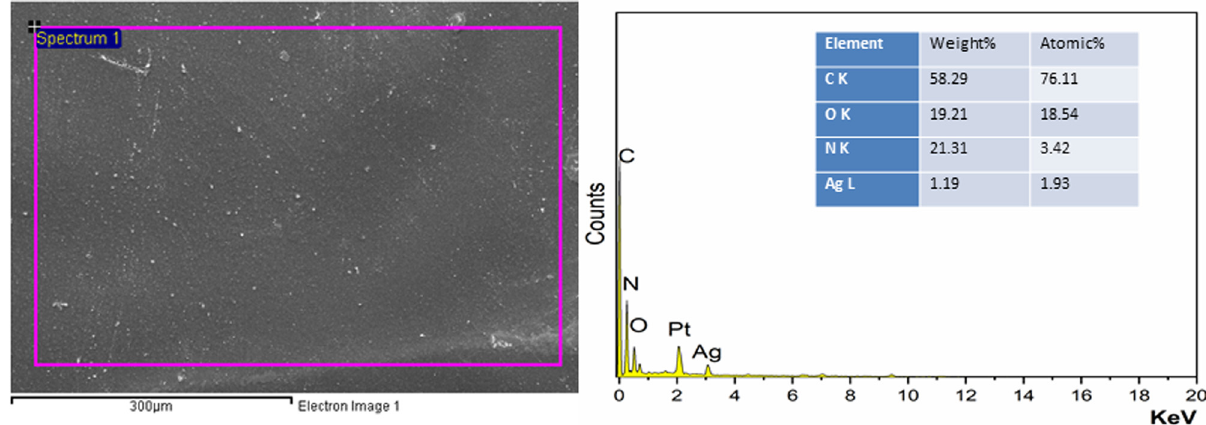
Figure 5: SEM – EDX micrograph of ROHA/SNP nanocomposite coating.